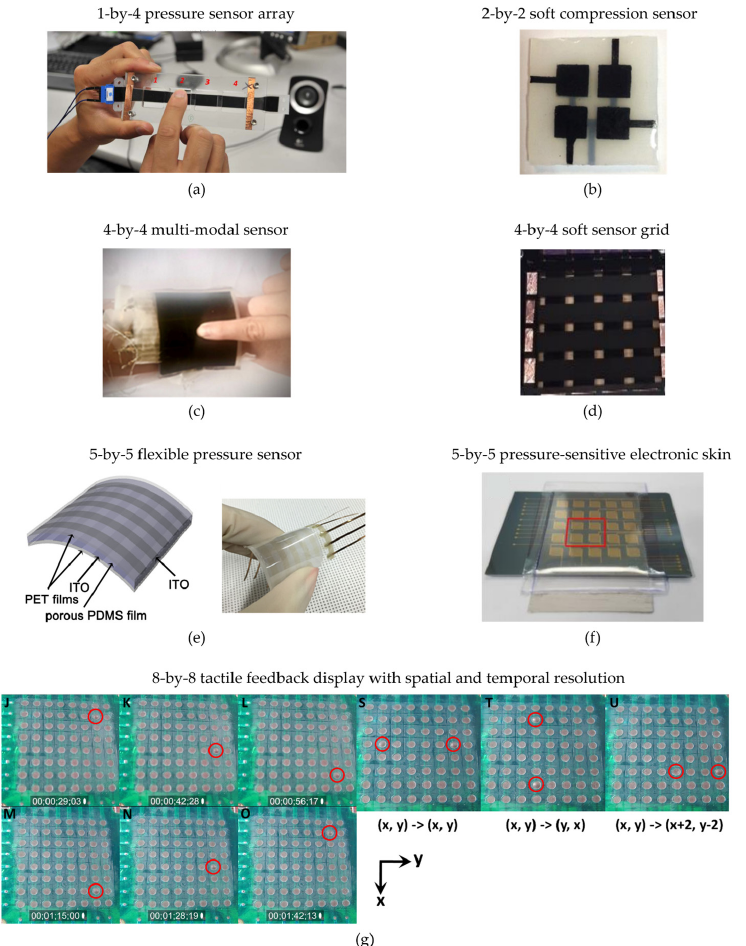
Figure 15. Examples of arrays of DES: ( a ) 1 ‐ by ‐ 4 pressure sensor array [160], reproduced with permission from John Wiley and Sons, copyright 2015; ( b ) 2 ‐ by ‐ 2 soft compression sensor [161], reproduced with permission from IOP Publishing Ltd., copyright 2016; ( c ) 4 ‐ by ‐ 4 multi ‐ modal sensor for simultaneous detection of amplitude and location of touch pressure [164]; ( d ) 4 ‐ by ‐ 4 soft sensor grid [165], reproduced with permission from SPIE, copyright 2020; ( e ) 5 ‐ by ‐ 5 flexible pressure sensor [166], reproduced with permission from Elsevier, copyright 2016; ( f ) 5 ‐ by ‐ 5 pressure ‐ sensitive electronic skin [168], reproduced with permission from Royal Society of Chemistry, copyright 2017; ( g ) 8 ‐ by ‐ 8 tactile feedback display with spatial and temporal resolution [170], reproduced with permission from Springer Nature, copyright 2013.